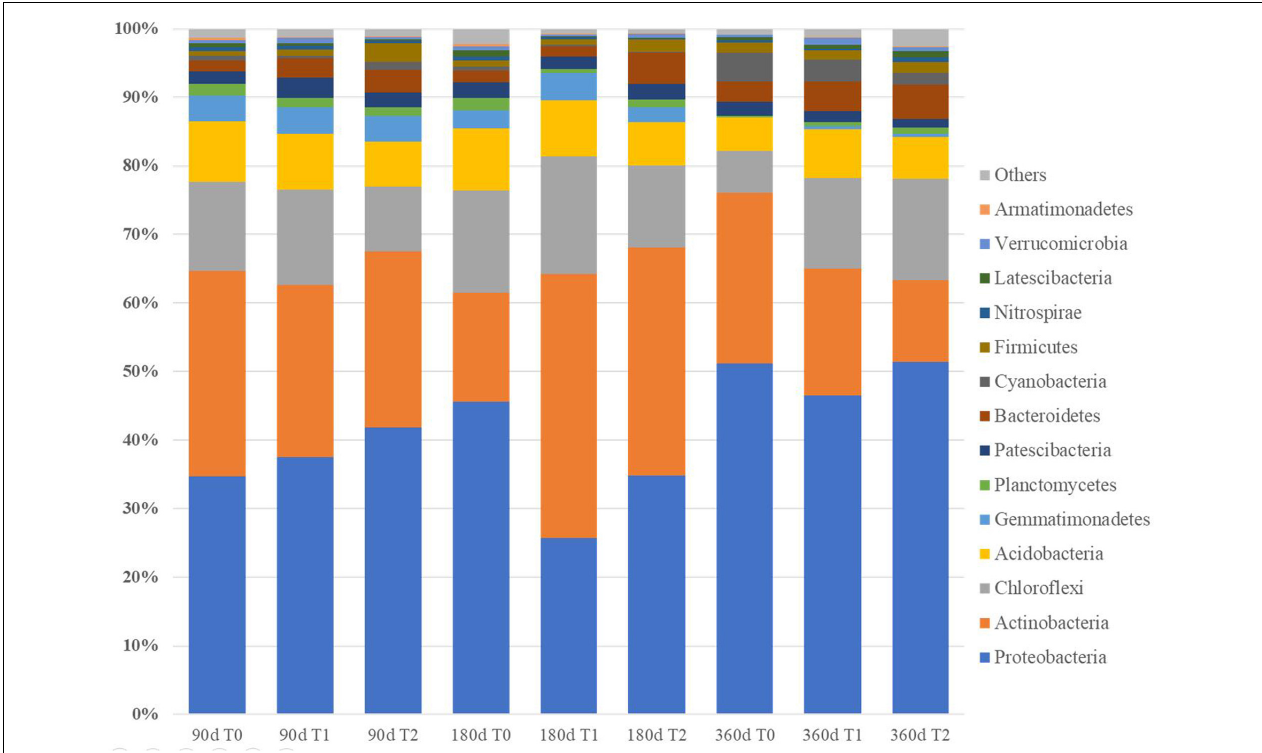
FIGURE 3 | Bacterial community composition in the tailing sand at the phylum level. T0, iron tailing sand + soil; T1, iron tailing sand + soil + Pennisetum giganteum ; T2, iron tailing sand + soil + bio-matrix pot + Pennisetum giganteum ; 90 d, 180 d, and 360 d indicate the sampling time in days after the start of the experiment.